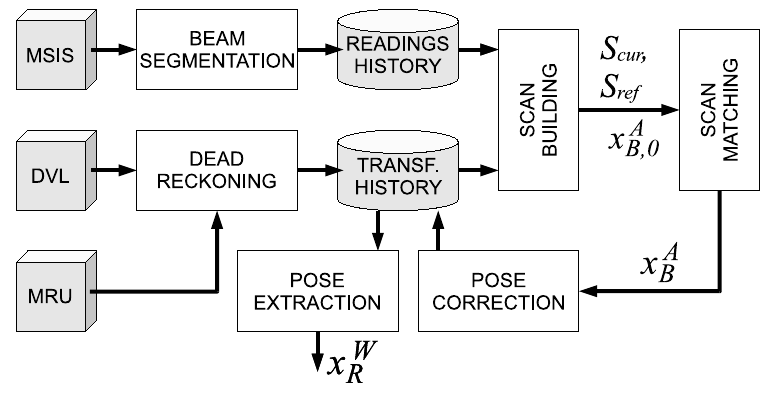
Figure 5. Overview of the uspIC. The notation is explained throughout the